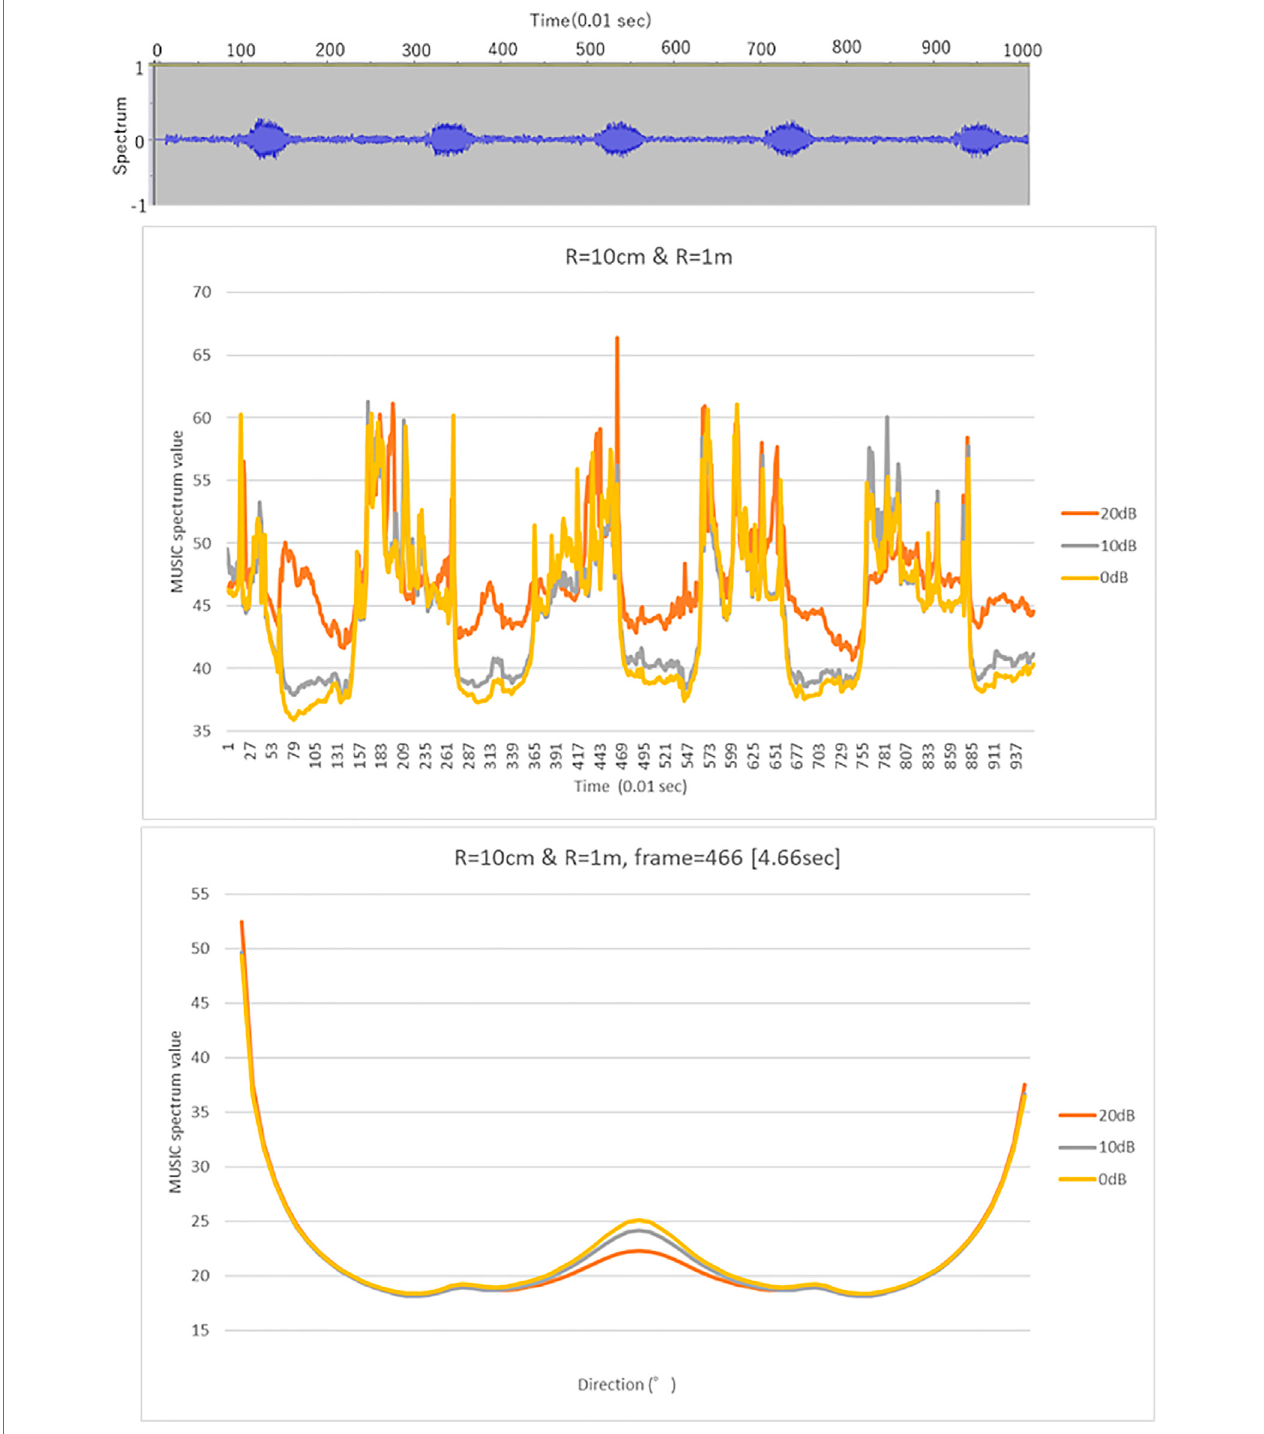
FIGURE 13 | MUSIC temporal spectrum (top) and temporal spectrum (bottom) in LF for the hybrid microphone array.